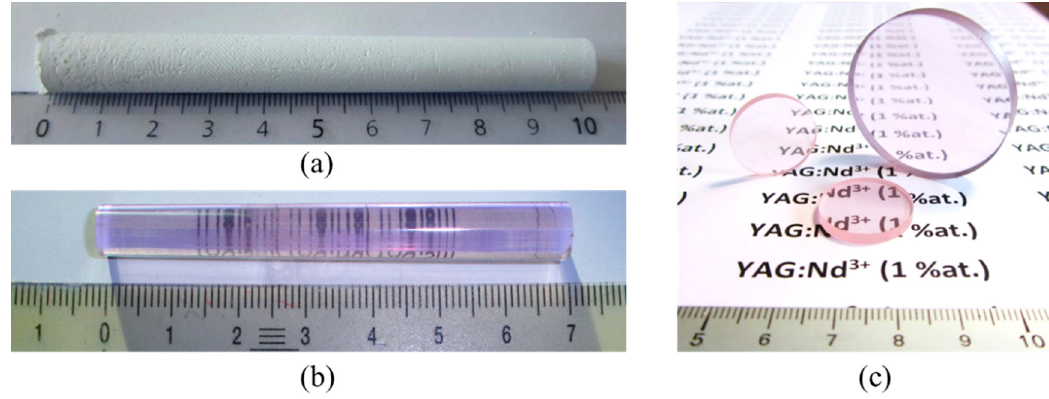
Figure 11. View of 1% Nd:YAG ceramics in the form of a barrel with a 100 mm length after shaping by pressure slip-casting ( a ), after presintering under vacuum + post-HIP at 1625 °C for 30 min under 190 MPa of argon ( b ), and in the form of discs of various sizes ( c ).